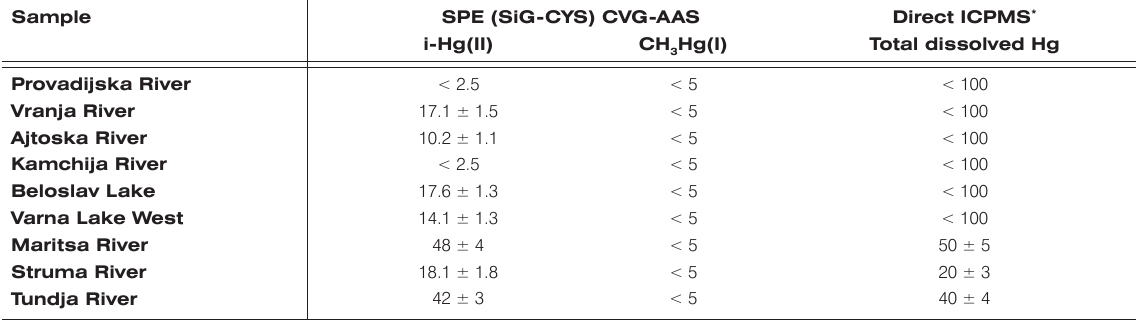
Table 4. Comparative analyses of river and Black sea water samples by proposed procedure and by direct ICP-MS without enrichment, ng L −1 (mean of 3 measurements ± sd.).